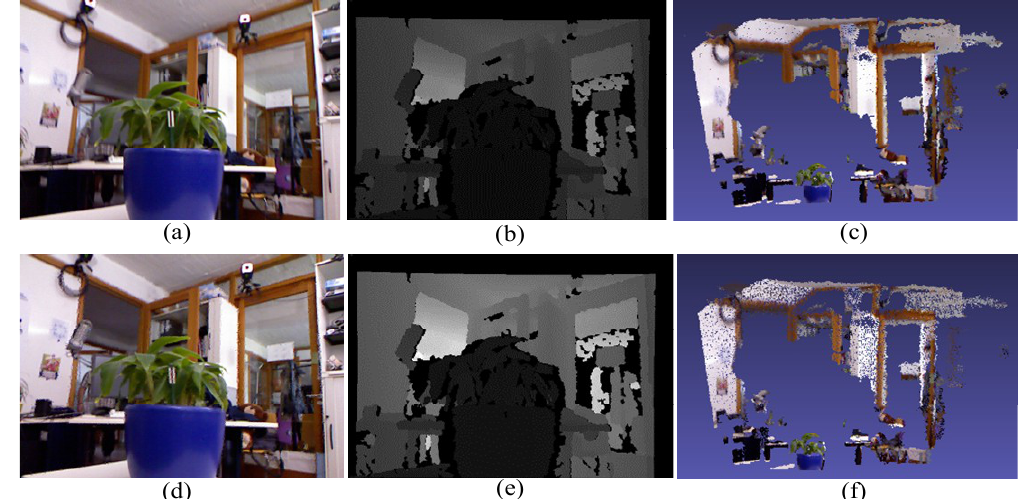
Figure 3. An example of the proposed binary tree representation algorithm for 3D reconstruction: ( a , b ) are the original RGB and depth images, respectively; ( c ) is the 3D point cloud generated from ( a , b ); ( d , e ) are the super-pixel representation of ( a , b ), respectively; ( f ) is the super-point representation of ( c ).